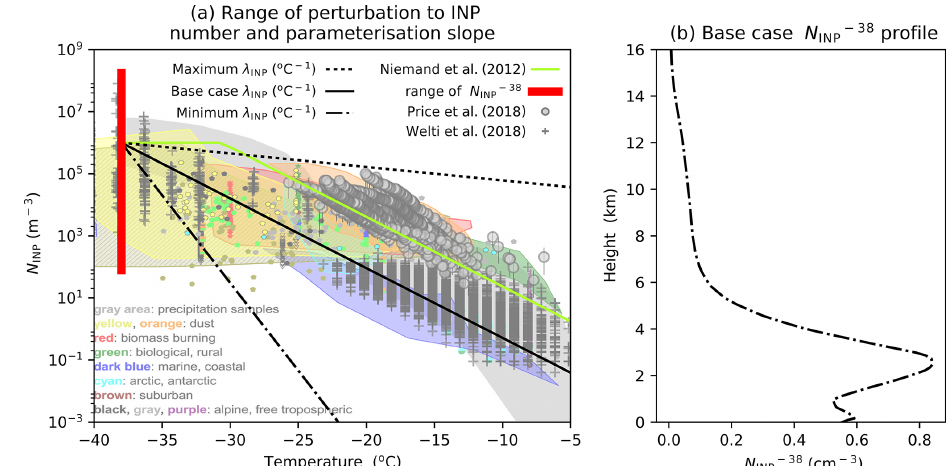
Figure 4. INP parameterisation slopes ( λ INP ) and INP concentration profiles. The base case (black solid line), maximum/steepest (black dash-dotted line), and maximum/shallowest (black dashed line) perturbations to λ INP are shown in panel (a) for an aerosol concentration of 1cm − 3 and a radius of 1µm. The Niemand et al. (2012) parameterisation (light green solid line) is also shown. The INP parameterisations are overlain on Figs. 1–10 from Kanji et al. (2017) (©American Meteorological Society, used with permission), showing observed INP concentrations along with some recent measurements from Cabo Verde in grey (Price et al., 2018; Welti et al., 2018). Panel (b) shows the base case N INP − 38 . Also shown in Fig. 1a is the range of N INP − 38 values (red bar), achieved by perturbing the profile shown in Fig. 1b. The range of N INP − 38 values shown by the red bar in Fig. 4a relate to the peak concentration shown in Fig. 4b at ∼ 3km. Figure 4b shows the profile that the simulation was initiated with. The aerosols can be advected around, and the peak values shown in Fig. 4b are lifted to all cloud levels by the convective updraught (not